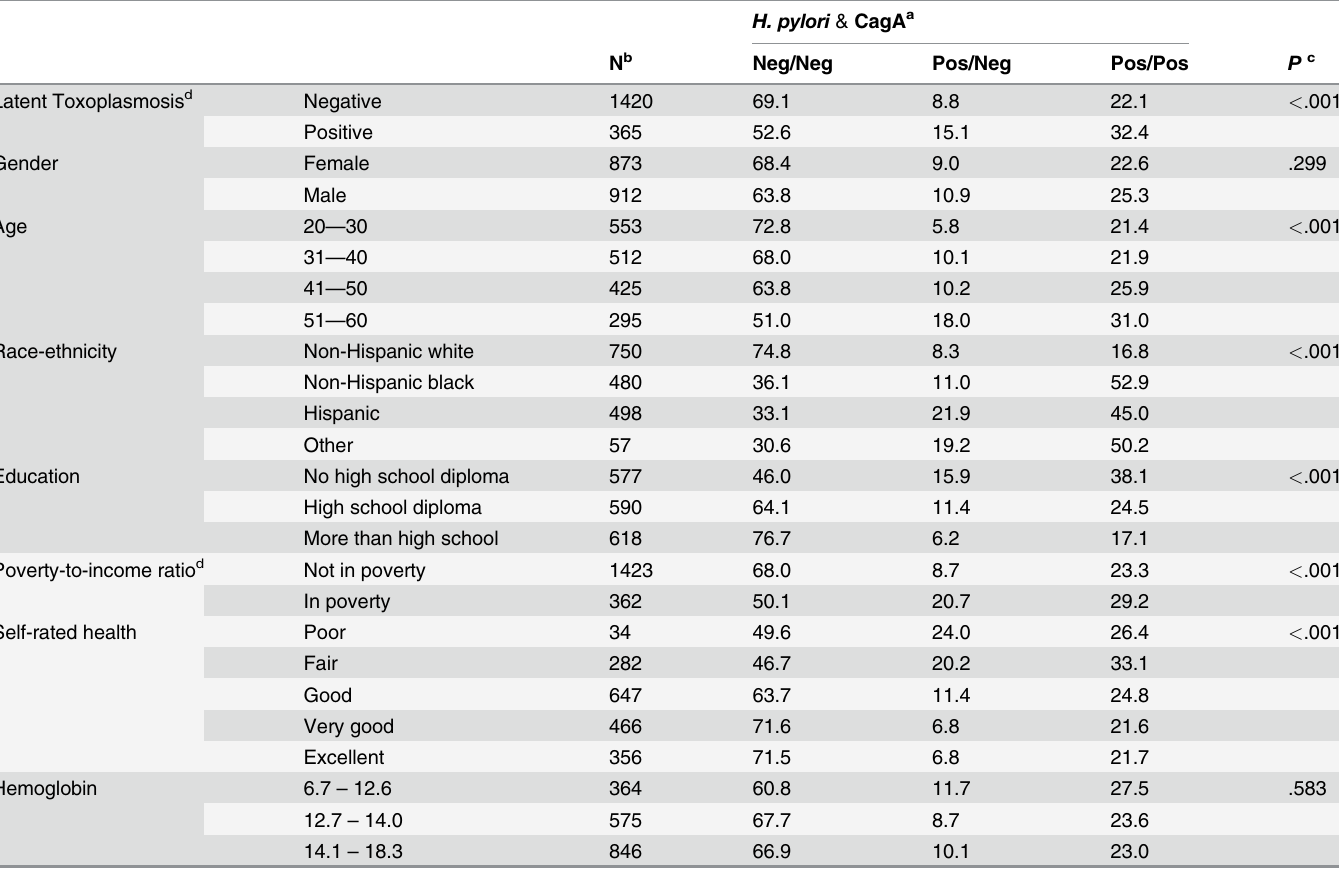
Table 1. Weighted Prevalence of Helicobacter pylori Across Demographic Characteristics in US 21 to 59 Year-Olds, NHANES III (1988 –